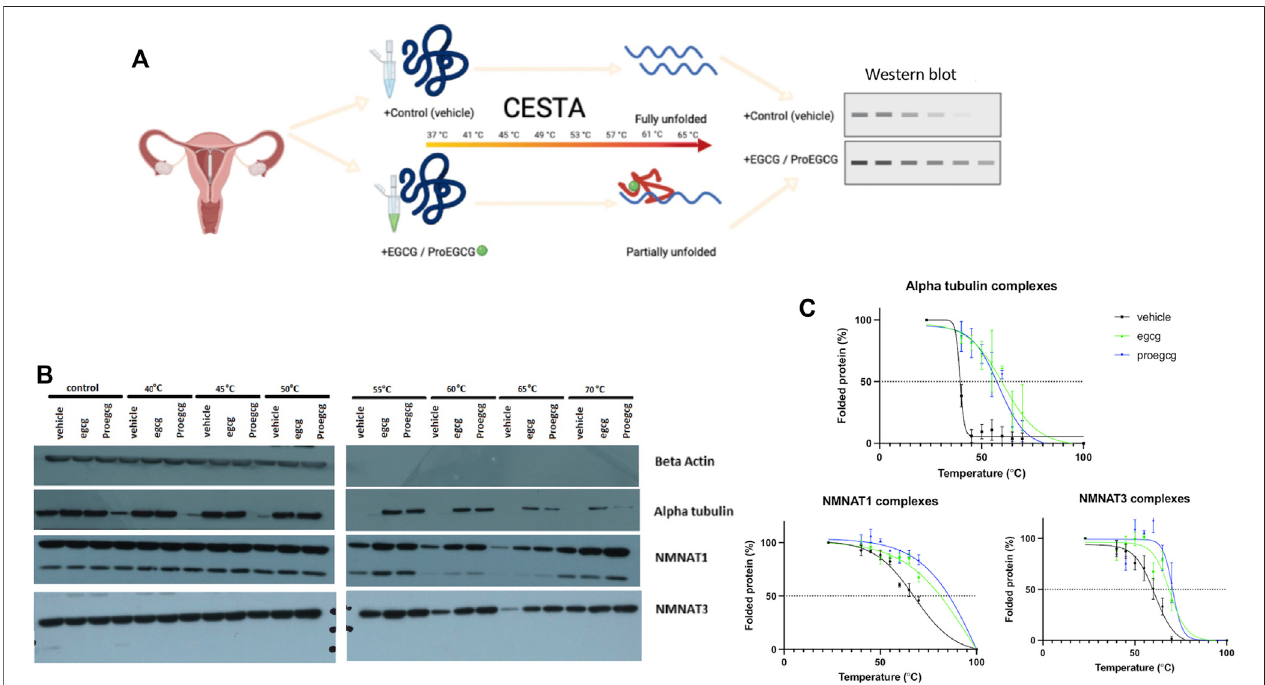
FIGURE4| CESTA invitro bindlingassays. (A) Schematicdiagram showing the invitro binding assay, Cellular Thermal Shift Assay (CESTA), toverify direct protein targetsofEGCGandProEGCG.Targetproteinsofdrugsareresistancetothermalheatingduetoproteinstructurewasstabilizedupondrugbinding,thusproteinswillbe partially unfolded; that without drug binding will be fully unfolded. (B) Western blot analysis was performed in triplicates for CESTA, representative western blot shows stronger intensities indrug binding targetsproteins than vehicle, upon thermal heating. (C) Meltingcurves ofCESTA. Relative band intensities were plotted against correspondingincubationtemperaturesofeach proteinligandcomplexes, asmean ± SD( n (cid:1) 3).Boltzmannsigmoidal fi twasapplied. Melting curvesweregeneratedby GraphPad Prism. NMNAT1: Nicotinamide Nucleotide Adenylytransferase 1; NMNAT3: Nicotinamide Nucleotide Adenylytransferase